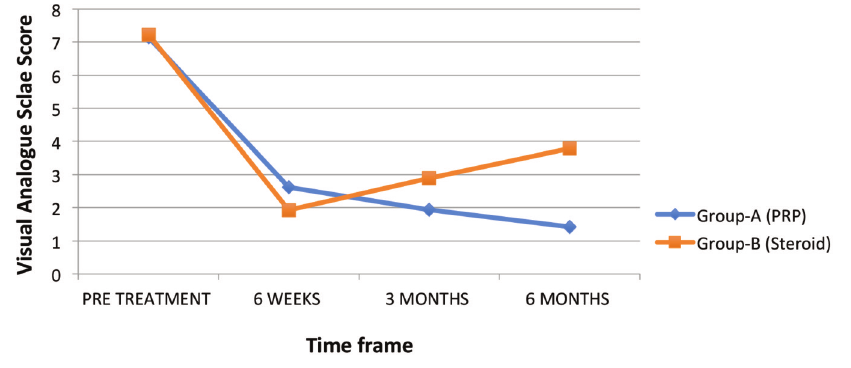
Representation of VAS scores before treatment and at interval of six weeks, three months and six months after treatment. Fig. 1: